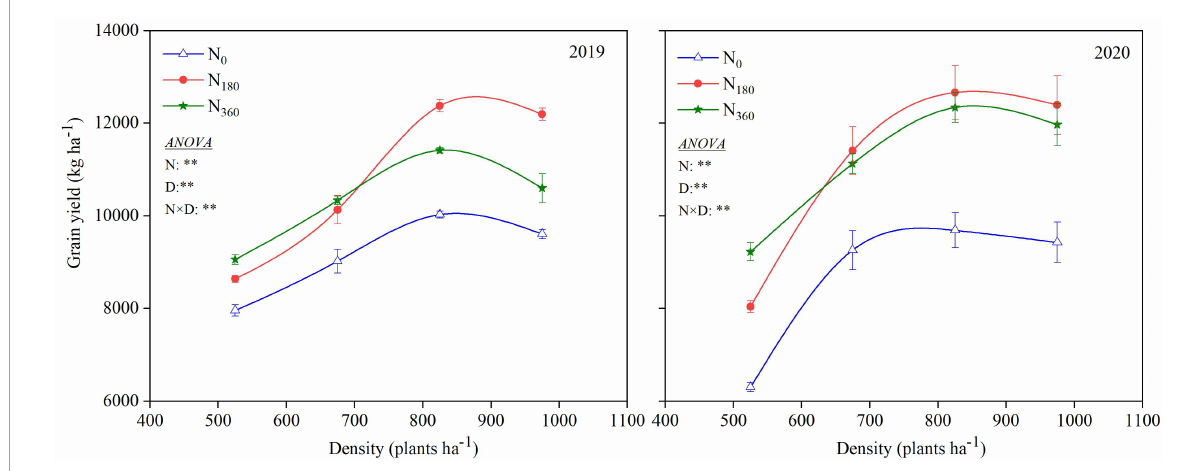
FIGURE3 Influence of N rate and plant density on the grain yield.